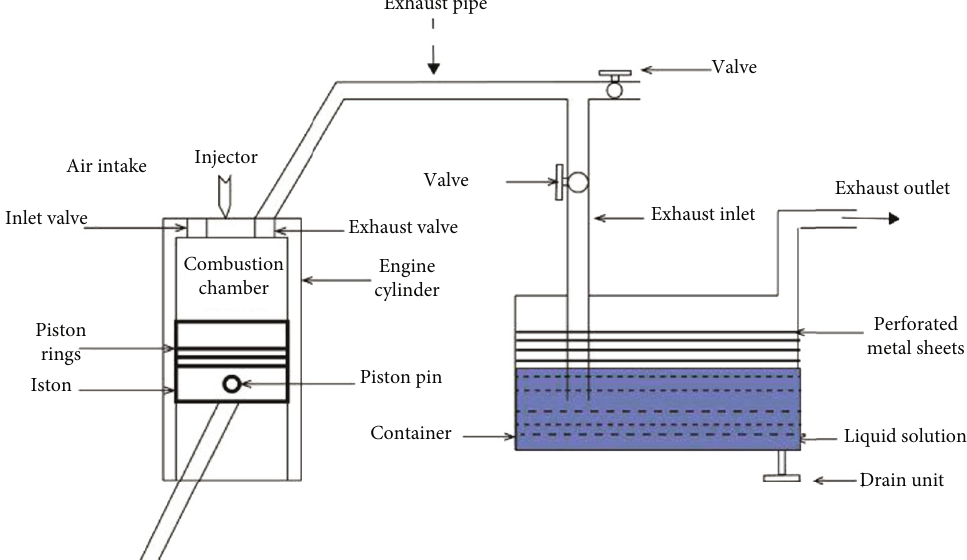
Figure 6: Layout of CO